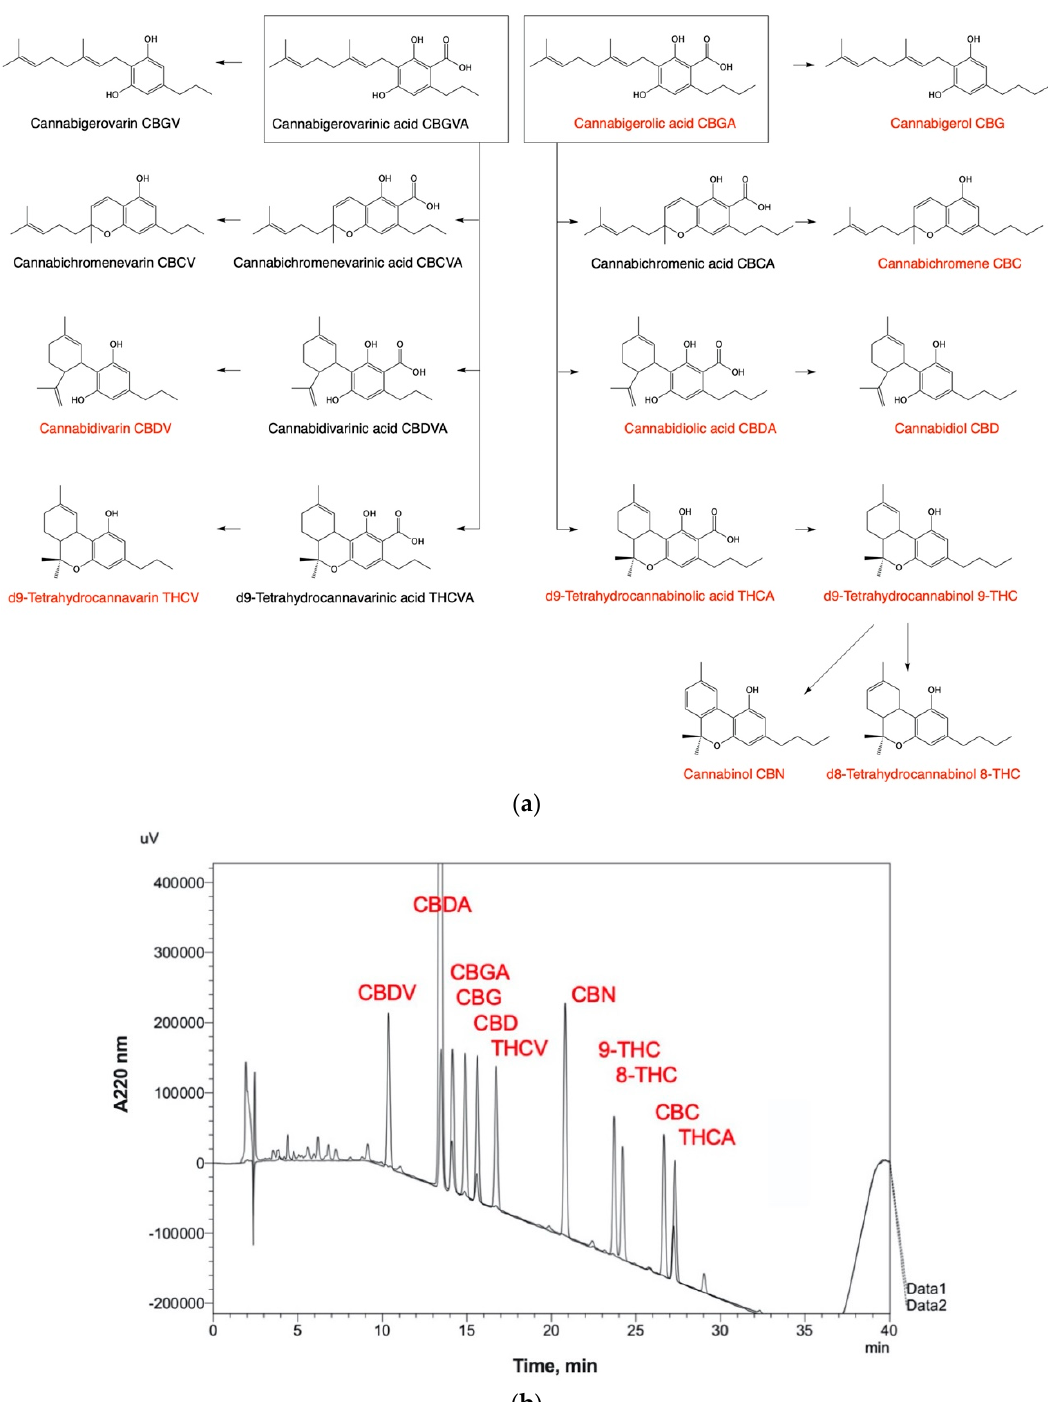
Figure 2. Major biosynthetic routes and cannabinoid metabolites found in Cannabis sativa tissues and botanical extracts. ( a ) The corresponding decarboxylation products are formed during collection, storage, and thermal processing of plant tissues. ( b ) HPLC-UV detection and full baseline resolution of 11 major cannabinoids using Shimadzu Prominence LC-2030C workflow as outlined in Table 1.